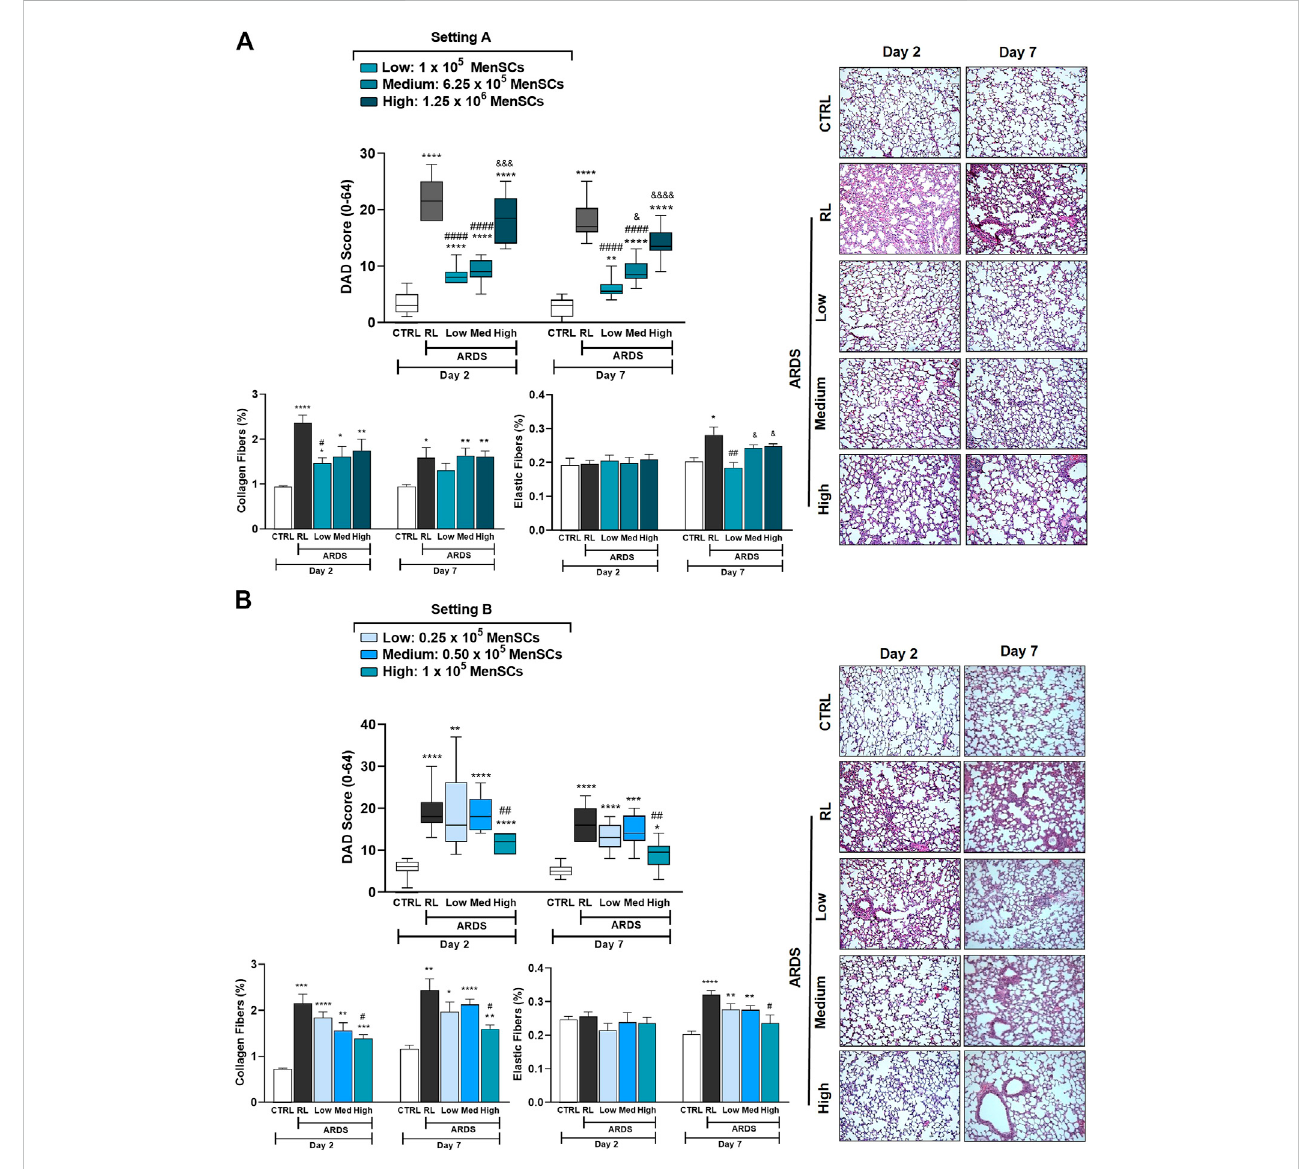
FIGURE 5 Reduction of the diffuse alveolar damage (DAD) score and lung tissue remodeling in lung-injured animals. The cumulative DAD score was calculated at (A) setting A and (B) setting B as the sum of each characteristic score (alveolar collapse, in fl ammatory in fi ltration, interstitial oedema, and septal thickening), andrangedfrom0to64.Right:DADscoreplots,representativeimagesoflungparenchymastainedwithhaematoxylin-eosin.Magni fi cation,×100.Scalebars, 50 μ m. Values are expressed as medians, interquartile ranges. For (A) setting A and (B) setting B, lung tissue samples were treated, and speci fi c staining methods were used to quantify the content (%) of collagen fi bers (Picrosirius polarization) and elastic fi bers (Weigert ’ s resorcin-fuchsin, modi fi ed with oxidation),atdays2and7afterLPSorRLadministration.Valuesareexpressedasthemean±standarderrorofthemean.*Signi fi cantlydifferentfromtheCTRL group (* p ≤ 0.05, ** p ≤ 0.01, *** p ≤ 0.001; **** p ≤ 0.0001). # Different from the RL group ( # p ≤ 0.05, ## p ≤ 0.01, #### p ≤ 0.0001). & Different from the low MenSCs dose ( & p ≤ 0.05, &&& p ≤ 0.001, &&&& p ≤